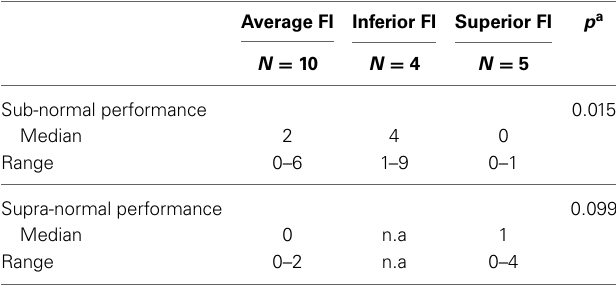
Table 3 | Extreme ranges of performance of AS participants divided in terms of individual differences in FI * .